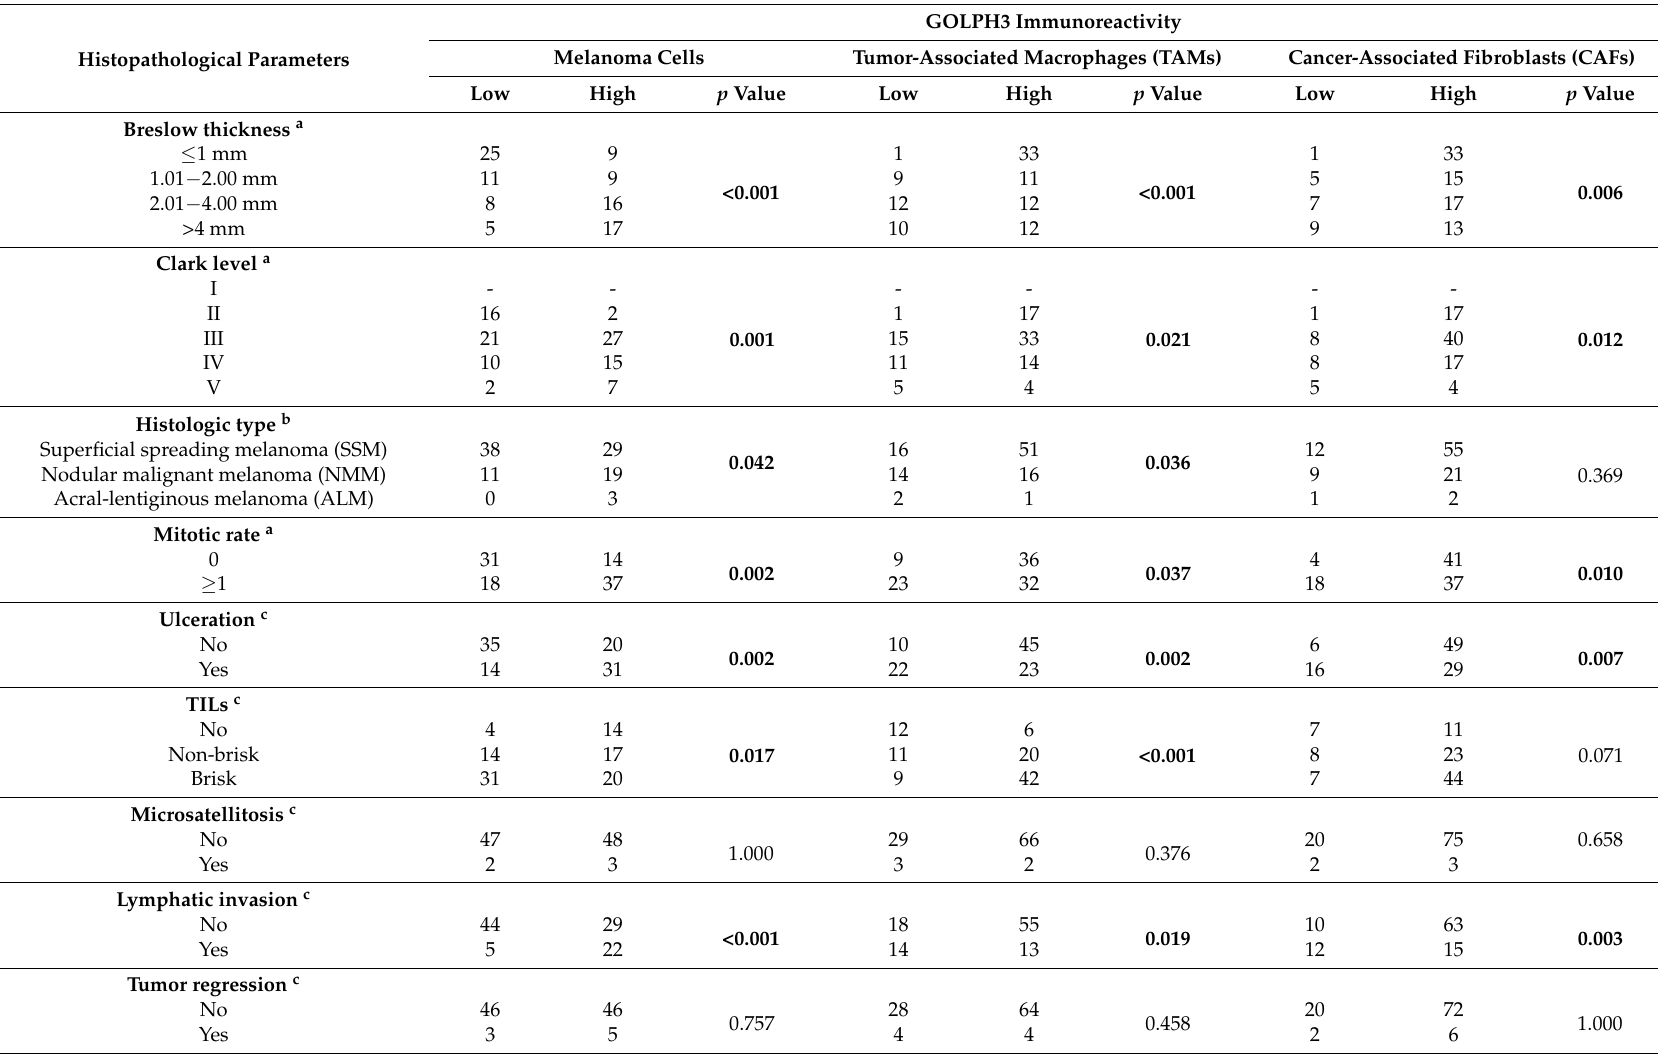
Table 4. Correlations between GOLPH3 immunoreactivity in melanoma cells, tumor-associated macrophages and cancer-associated fibroblasts, and pathological parameters.